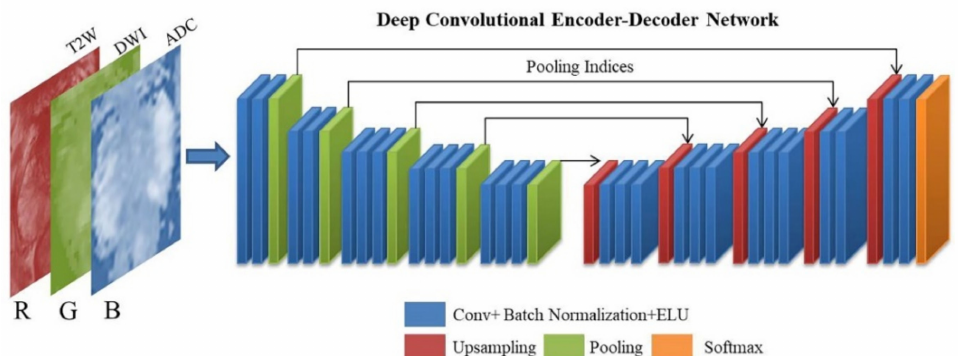
Figure 2. Schematic of the modified SegNet